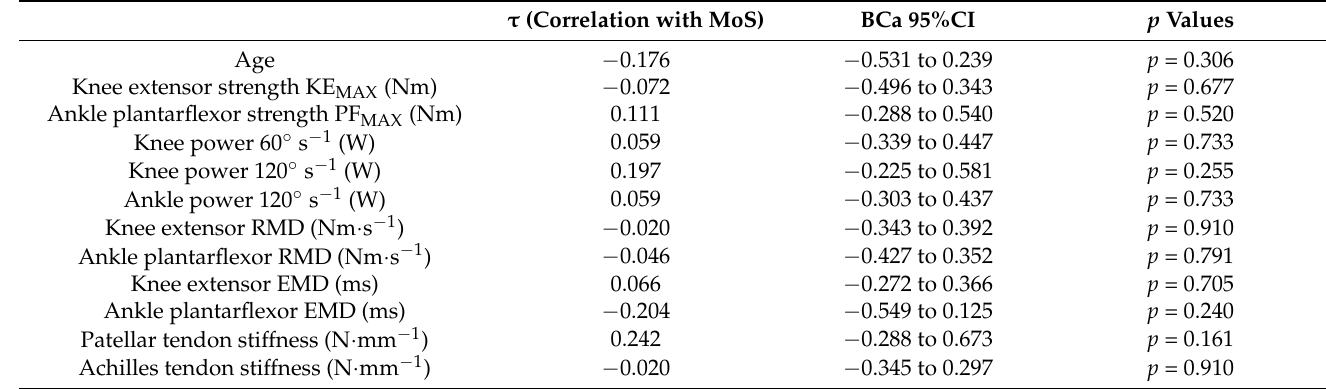
Table 3. Correlation table using Kendall’s tau between participants’ age or MTUs properties and